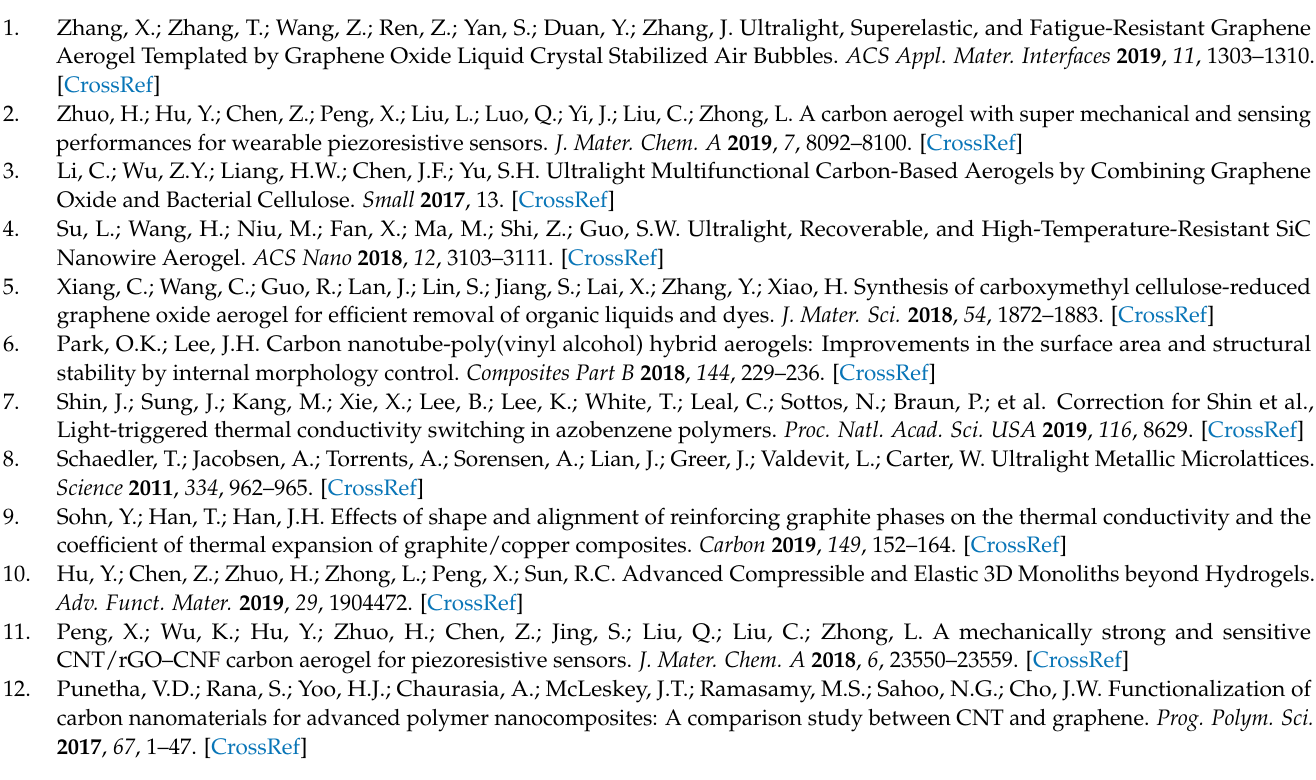
images of the top parts ((a), (c)) and sheets surfaces ((b), (d)) of the CNT/CMC2(2.5_10) ((a), (b)) and CNT/CMC2(5_10) ((c), (d)). Figure S5: SEM images of the cross-sections ((a), (c)) and sheets surfaces ((b), (d)) of the CNT/CMC2(2.5_10) ((a), (b)) and CNT/CMC2(5_10) ((c), (d)). Figure S6: SEM images of the CNT/CMC sheets, and CNT/CMC sheet surfaces with different weight average molecular weight; (a) and (c) CNT/CMC1(1.3_10); (b) and (d) CNT/CMC3(1.3_10). Table S2: Pore volume and BET surface area obtained from BET N 2 sorption measurement. Figure S7: The pore-size distribution of the samples; (a): CNT/CMC1(1.3_10), (b): CNT/CMC2(1.3_10), (c): CNT/CMC3(1.3_10), (d): CNT/CMC4(1.3_10), (e): CNT/CMC1(1.3_20). Figure S8: (a), (b), (c) Stress–strain curves for the axial compression; (a) CNT/CMC2 (1.3_10), (b) CNT/CMC2(2.5_10), (c) CNT/CMC2(5_10). (d), (e), (f) Stress–strain curves for radial compression; (d) CNT/CMC2(1.3_10), (e) CNT/CMC2(2.5_10), (f) CNT/CMC2(5_10). Figure S9: Schematic diagrams of CNT/CMC sponge under compression; (a) CNT/CMC2(1.3_10), (b) CNT/CMC2(5_10). Figure S10: Relationship between CMC molecular weight and maximum stress when the CNT mass ratio was 10%. Figure S11: Relationship between cycle number and recovery rate when repeatedly compressing CNT/CMC1(1.3_10). Video S1: supplementary movie of the compressed